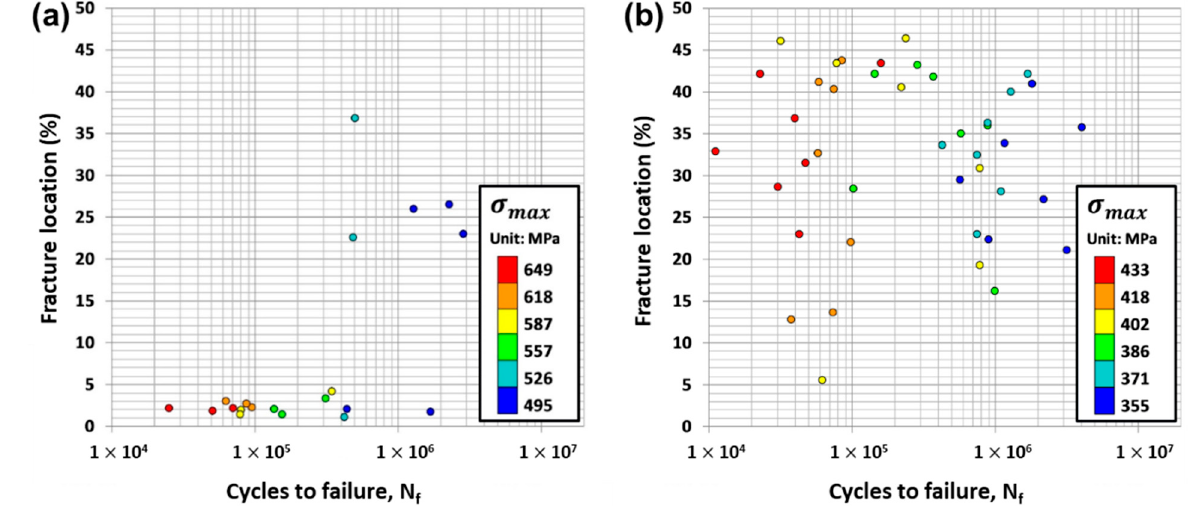
Figure 7. Variations of the fracture location as a function of fatigue life ( N f ) for different σ max values at ( a ) RT and ( b ) 1000 K.